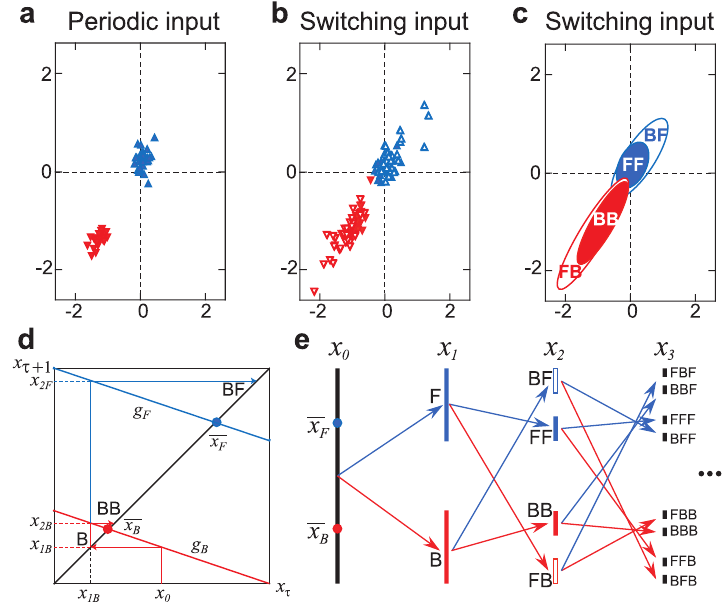
Figure 8. Examples of Poincaré sections Σ for periodic and switching input conditions. ( a ) Periodic input, ( b ) switching input, and ( c ) the ellipse of constant distance using each mean and ± 1 S . D . for switching input. ( d ) The return map shows the construction of the Cantor set with rotation using two iterative functions. The iterative functions g F and g B transform the state, x τ , to the next state, x τ + 1 . The transformations of the iterative functions g F and g B are rotated around the fixed points x F and x B , respectively. ( e ) The hierarchical structure of the fractal corresponds to the sequence of forehand (F) and backhand (B) inputs. Modified with permission from [40], Hum. Mov. Sci.